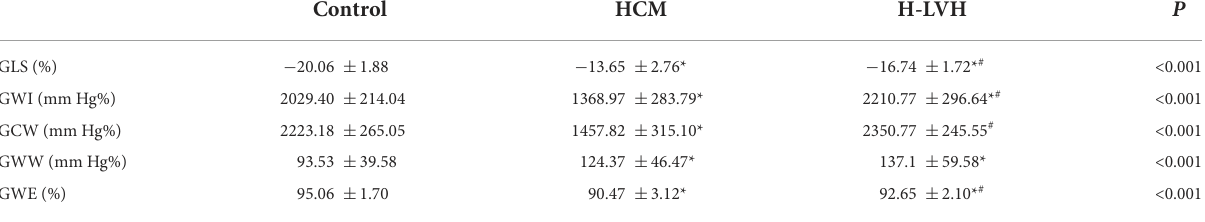
TABLE 3 Comparison of GLS and myocardial work parameters for study